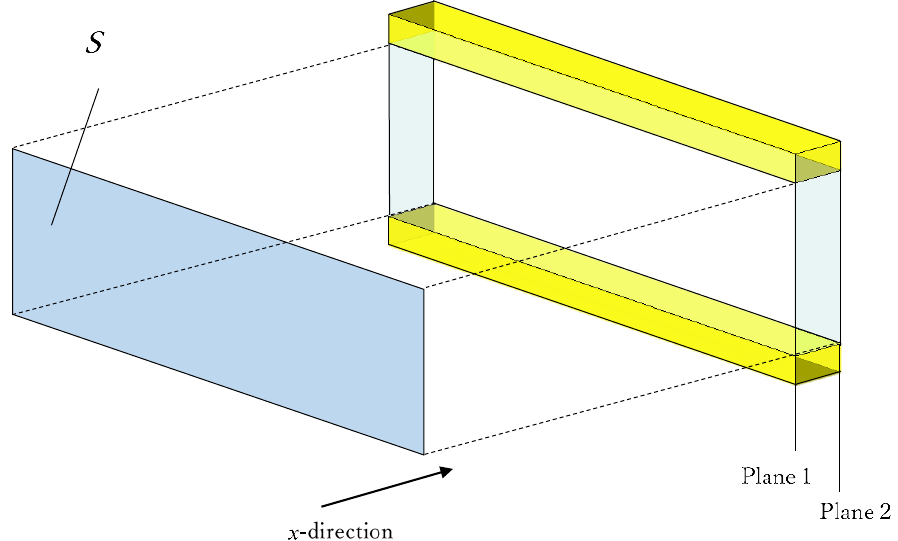
Figure 8. Cross-sectional shape at any position of the analysis unit (sound incident area and aperture area).